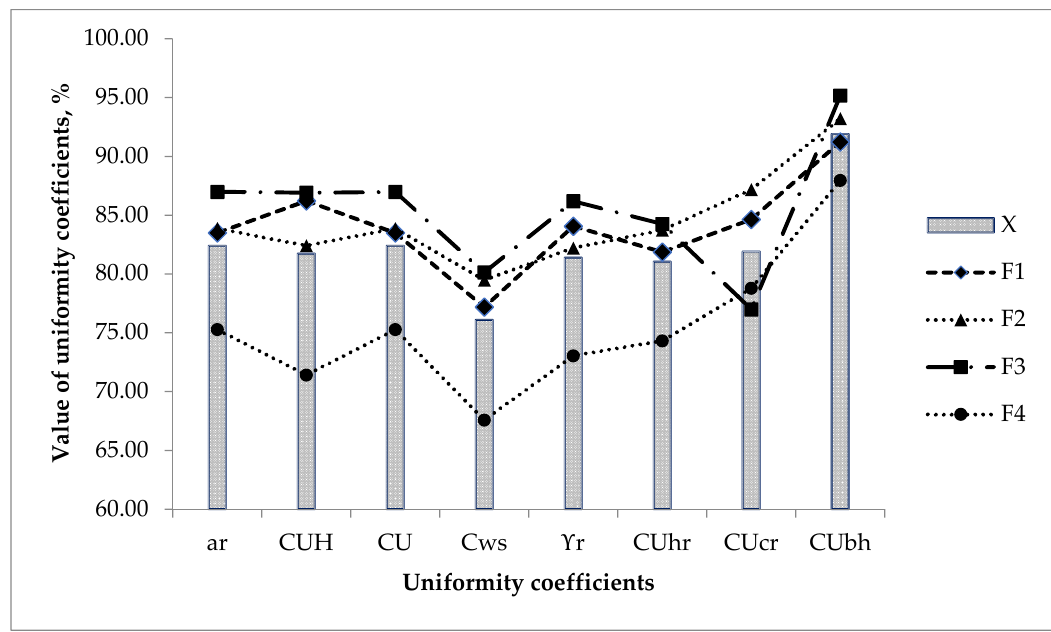
Figure 4. The results of different coefficients of uniformity for all experimental fields, for T1 where: ar—coefficient of uniformity according to Oehler, CUH—coefficient of uniformity according to Heerman and Hein, CU—coefficient of uniformity according to Christiansen, Cws—coefficient of uniformity according to Wilcox and Swailes, γ r—coefficient of uniformity according to Voigt, CUhr—coefficient of uniformity according to Hart and Raynolds, CUcr—coefficient of uniformity according to Criddle et al., X—average values in individual samples.